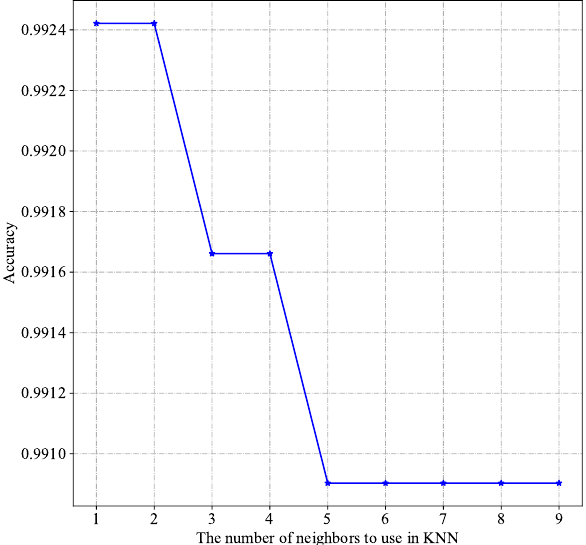
Figure 8. Performance comparison using different random forest (RF) parameters.